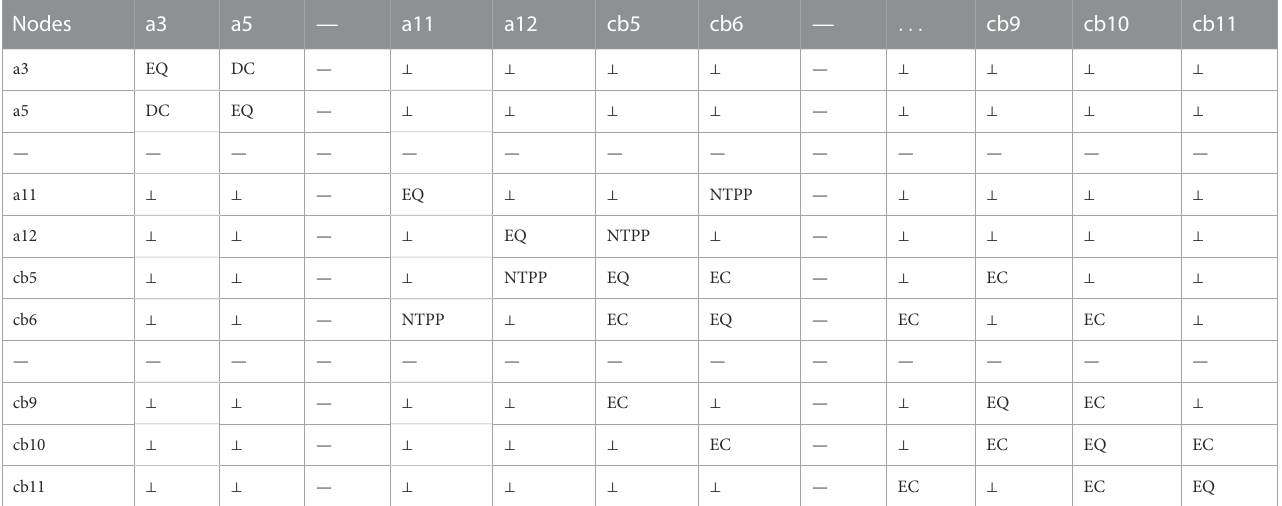
TABLE 1 The adjacency matrix of space relations of sketch maps in Figure